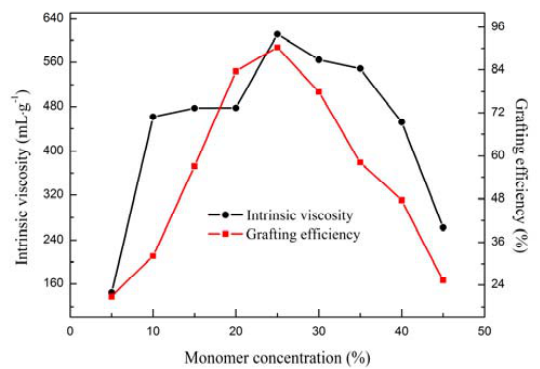
Figure 1. Effect of monomer concentration on intrinsic viscosity and grafting efficiency of carboxylated chitosan (CPCTS) ‐ g ‐ P (CTA ‐ DMDAAC).